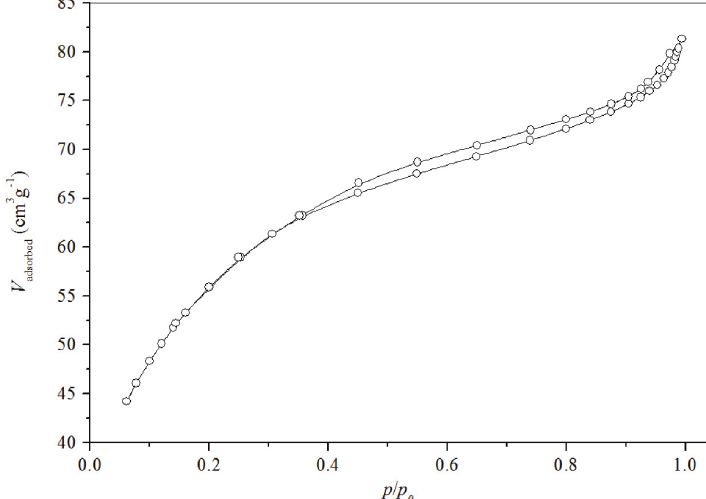
Fig. 4 – Nitrogen adsorption-desorption isotherms of the prepared